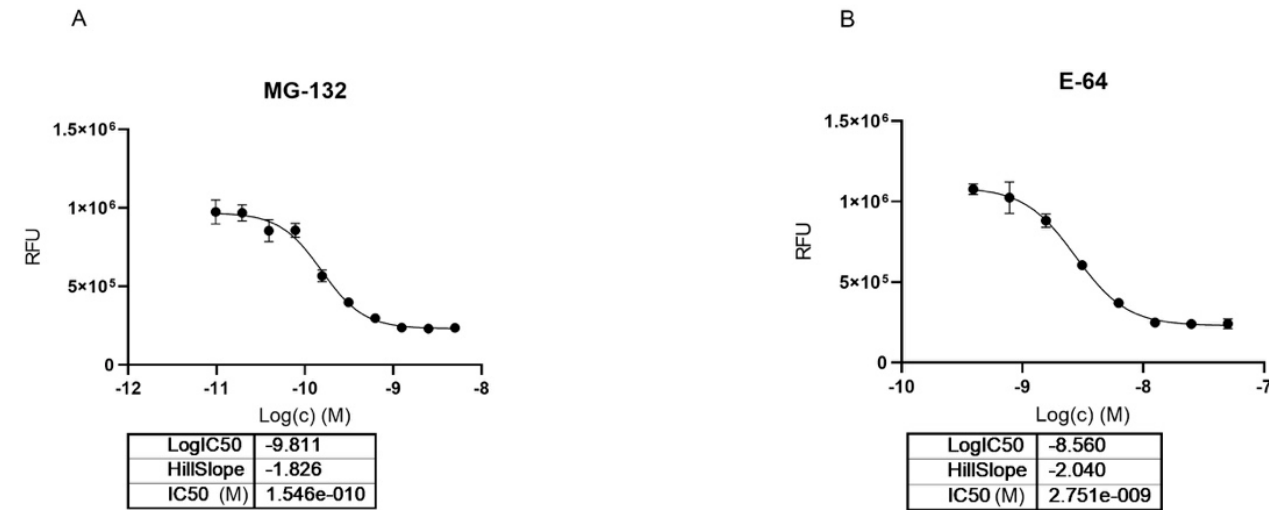
Figure 6. Dose dependent inhibition of Cathepsin-L using MG-132 ( A ) and E64 ( B ).